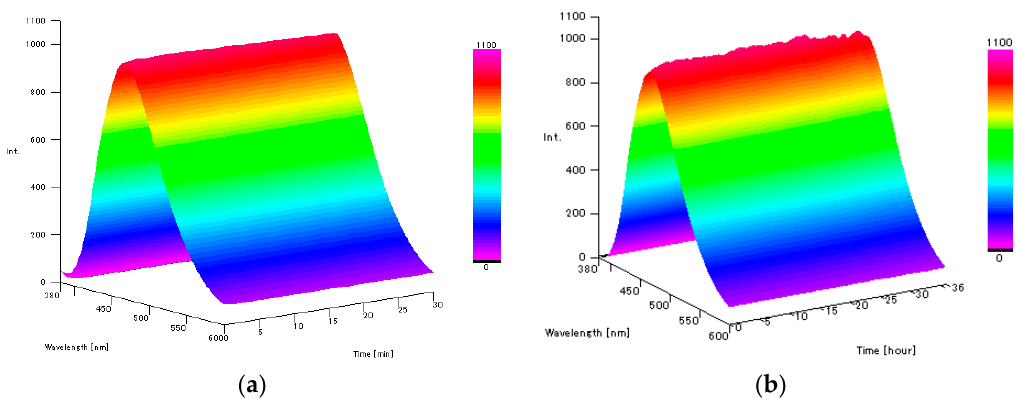
Figure 4. Variation in the fluorescence spectra of the 5-BPA complex in 50 vol % DMSO/PBS (0.2 mM, excitation wavelength: 355 nm) at 25 °C . ( a ) prepared after 0–60 min; ( b ) prepared after 0–36 h.